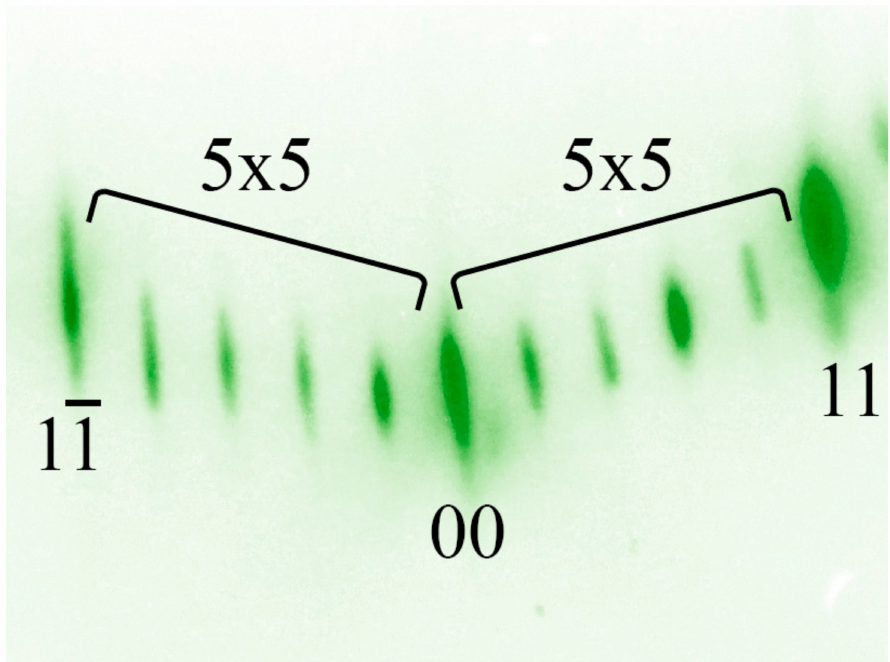
Figure 5. Diffraction pattern from the germanium layer on Si(111) with the 5 × 5 reconstruction at the later stages of